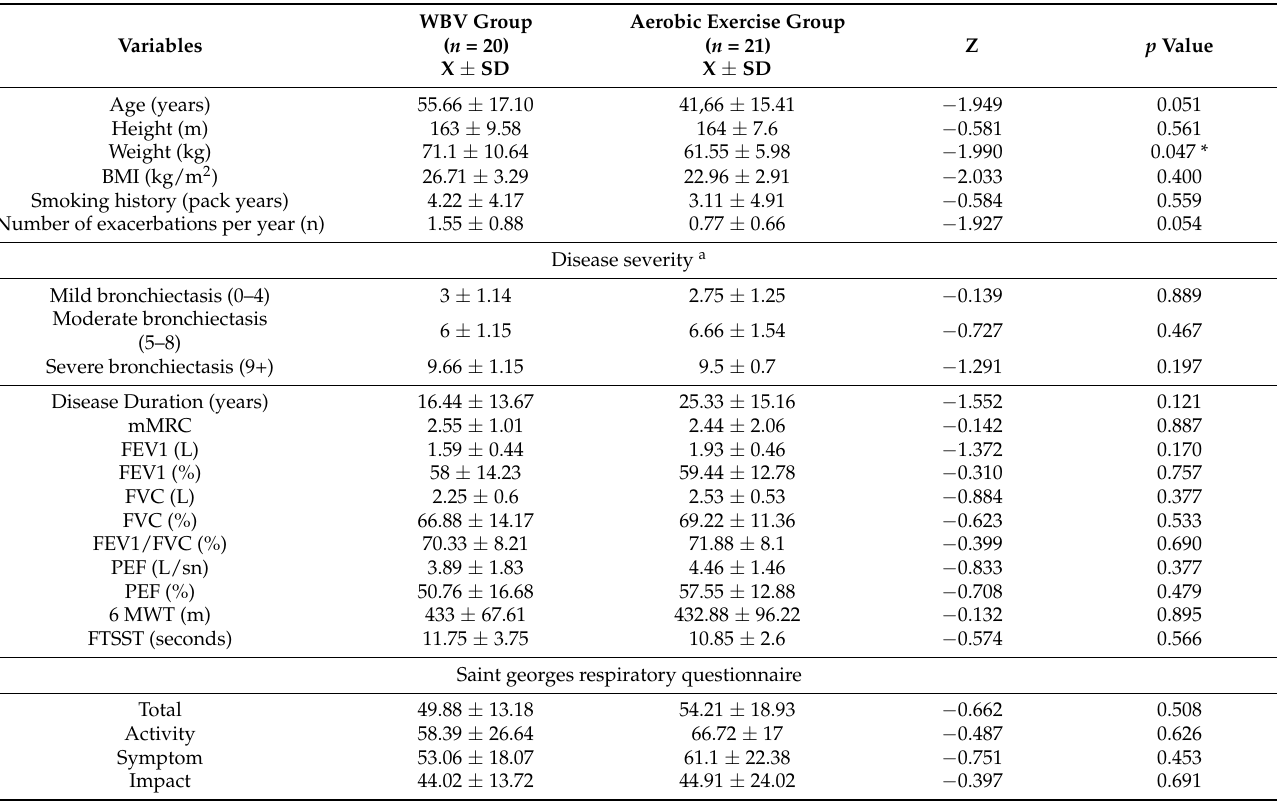
Table 1. Comparison of two groups in terms of baseline demographic, clinic and functional